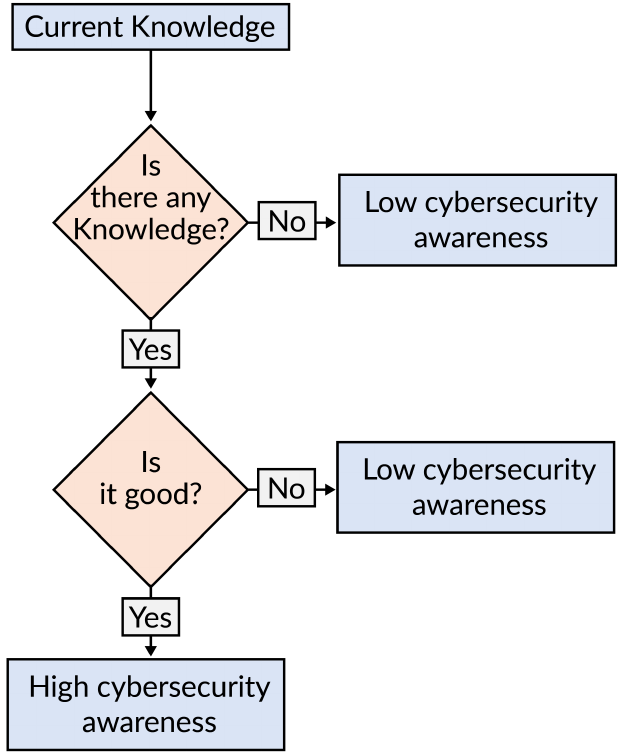
Figure 2. The process of defining the cybersecurity awareness of the